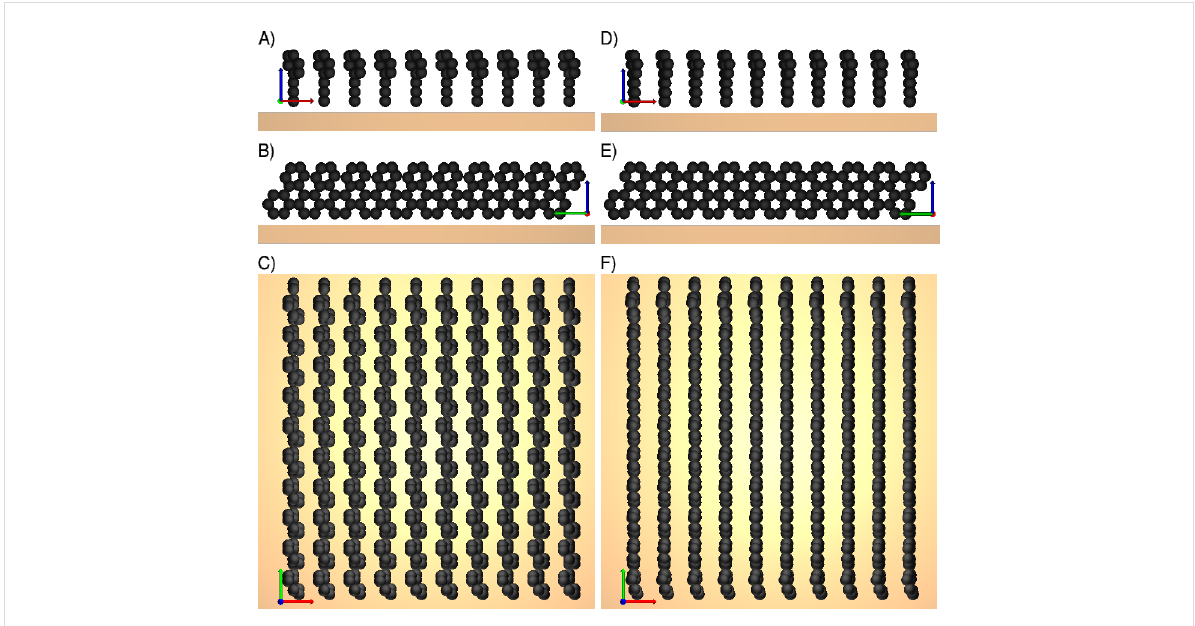
Figure 3: Front (A), side (B) and top (C) view of an initial state made of a regular (square lattice) arrangement of tilted biphenyl carbon skeletons. The tilt angle is γ = 30°. Front (D), side (E) and top (F) view of the resulting local energy minimum state, which consists of regular graphene stripes.